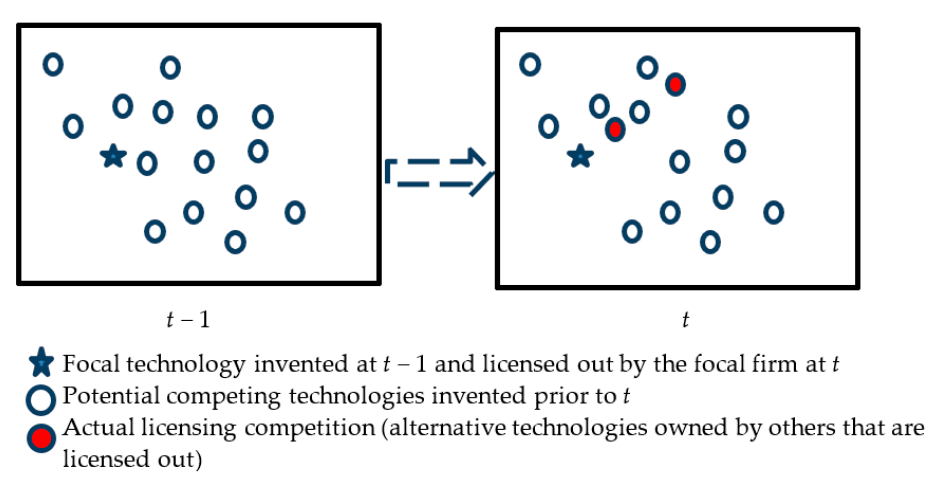
Figure 1. Illustration for the distinction between potential technology competition and actual licensing competition in a particular technology field.